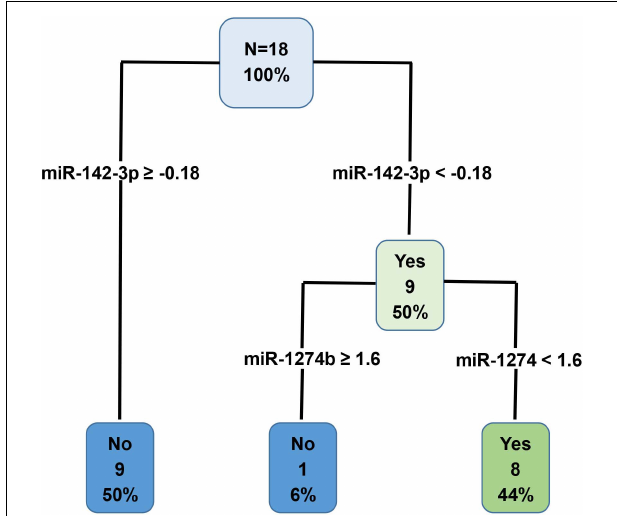
FIGURE 6 | Decision tree prediction model was generated using the Group A training dataset. Out of the 19 variables entered into the model, miR-142-3p and miR-1274b were identified as key variables in the prediction process. Specifically, these two miRNAs correctly predicted 100% of the Group A training